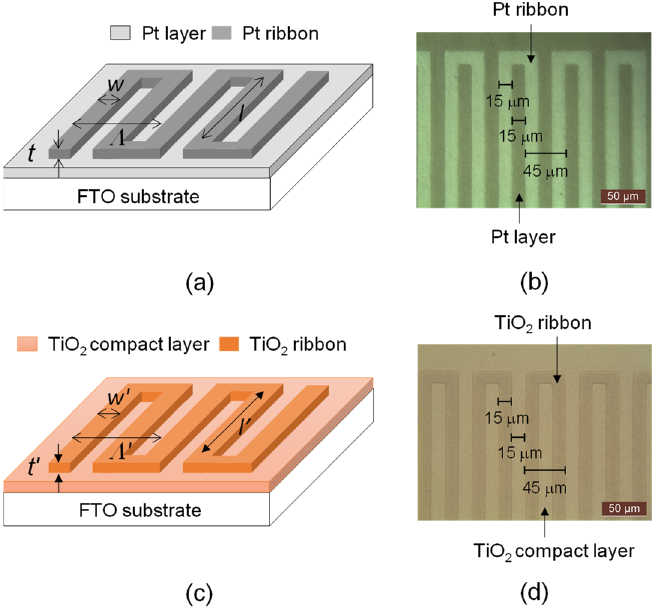
Figure 1. ( a ) Schematic diagram and ( b ) microscopic picture of a Pt ribbon deposited on an FTO substrate with a Pt layer. ( c ) Schematic drawing and ( d ) microscopic picture of a TiO 2 ribbon deposited on an FTO substrate with a TiO 2 compact layer.